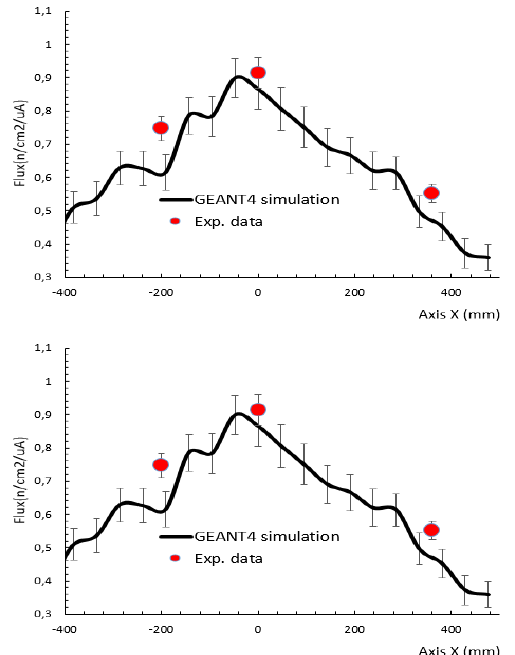
Fig. 6. Thermal neutron beam divergences at 8.4 m from the target. The positive direction of Y axis is in the proton beam’s side. The origin is at 8.4 m. Fig. 7 summarizes the thermal neutron flux measurements obtained from gold foil activation and time of flight measurement along the neutron flight path (red dots). The result of the simulation performed with GEANT4 is also provided. A very good agreement is obtained between the measurements and the simulation result. In this simplified moderator geometry, it is possible to obtain a thermal neutron flux of about 1000 cm -2 .s -1 at the exit of the moderator.